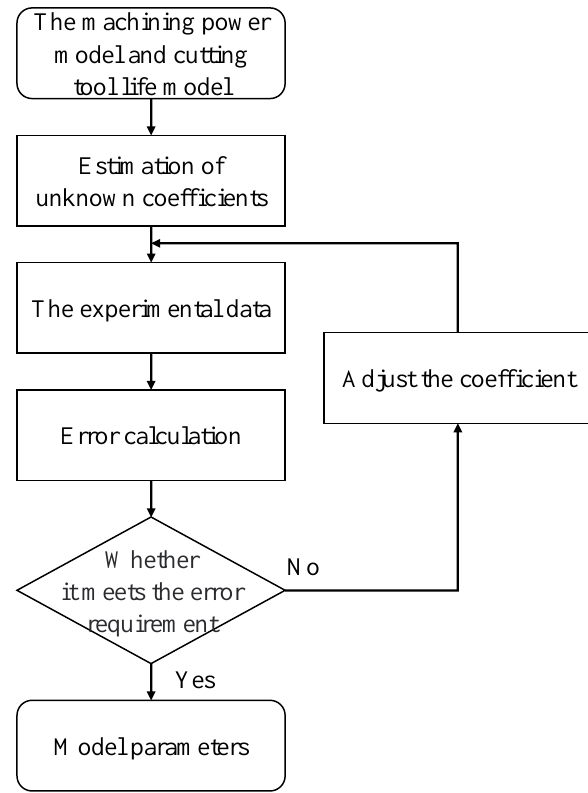
Figure 18. Multivariate linear regression method. Table 4. Cutting-tool degradation model.